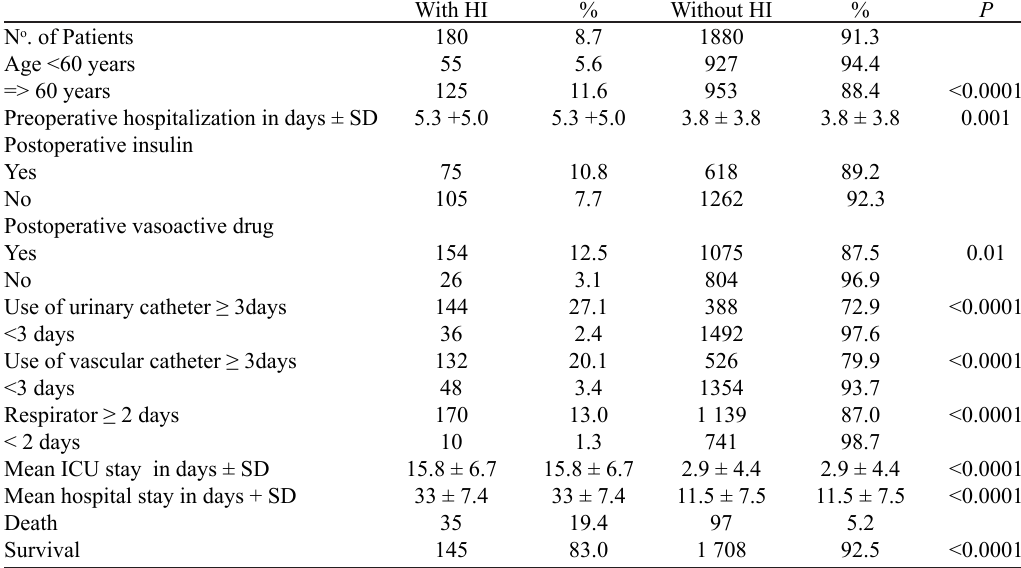
Table 3. Variables associated with the occurrence of nonsurgical hospital infection. N o . of